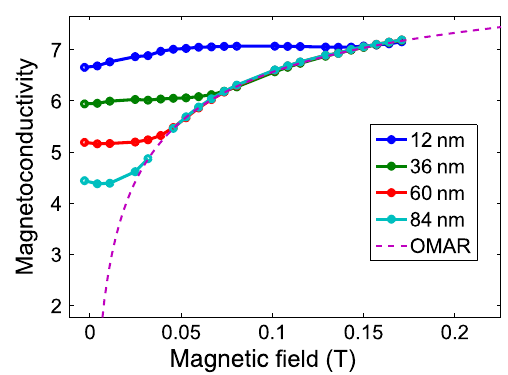
FIG. 16. Results of the uncorrelated B -field model. Computed organic magnetoconductivity caused by fringe fields of a magnetic electrode at different distances from the organic semiconductor. The magnetic fringe fields are determined from XMCD domain images of the magnetic electrodes. A large negative magnetic field first saturated the electrode. The com- puted curves correspond to the positive magnetic-field sweep of the black magnetization curve in Fig. 3. The purple dashed curve shows the OMAR response with a nonmagnetic